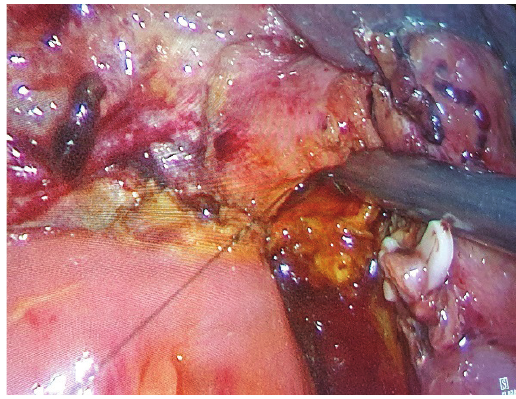
Figure 2: Hepaticojejunostomy